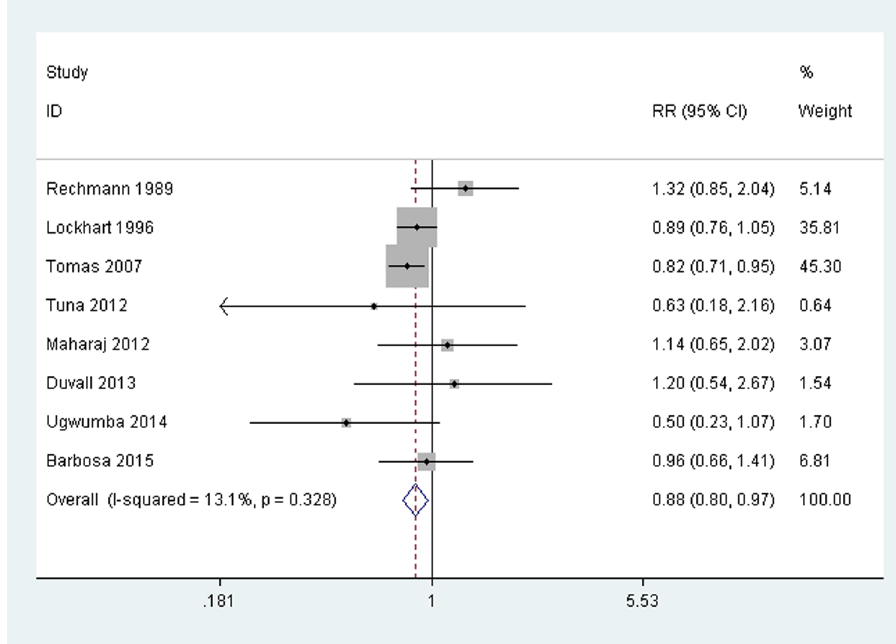
Fig 2. Forest plot. Relative risks (RR) for the effect of treatment with chlorhexidine on the incidence of bacteremia compared to control groups. Fixed-effect inverse variance weighted meta-analysis.